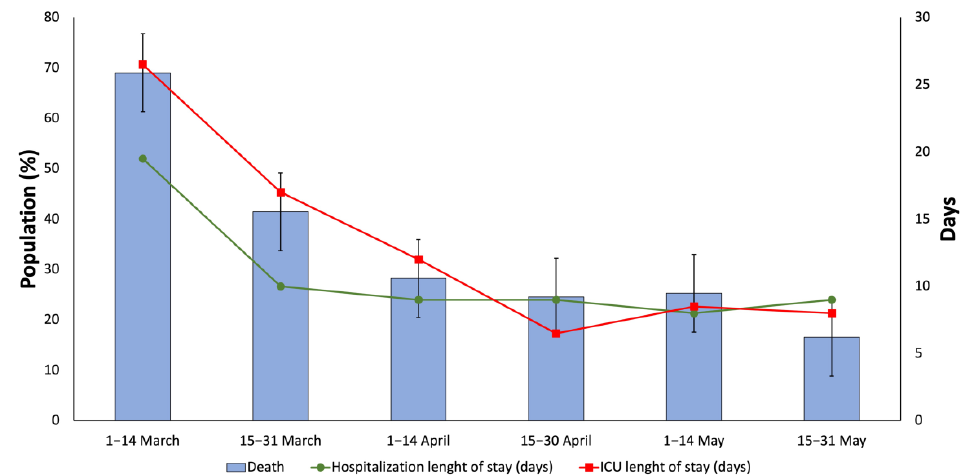
Figure 1. Biweekly clinical baselines in hospitalized COVID-19 patients with previous cardiovascu-